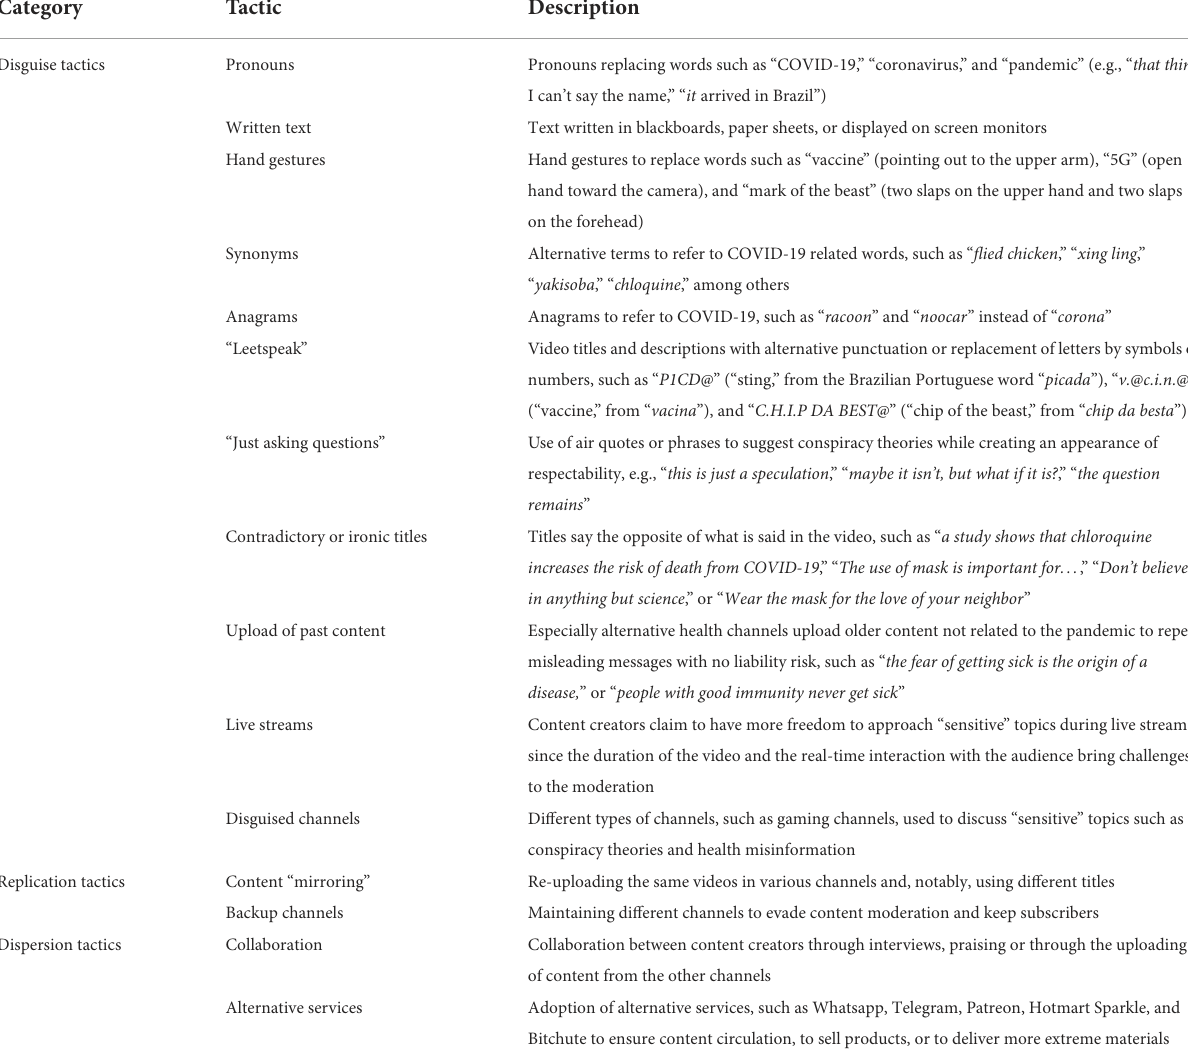
TABLE 3 Main tactics to evade content